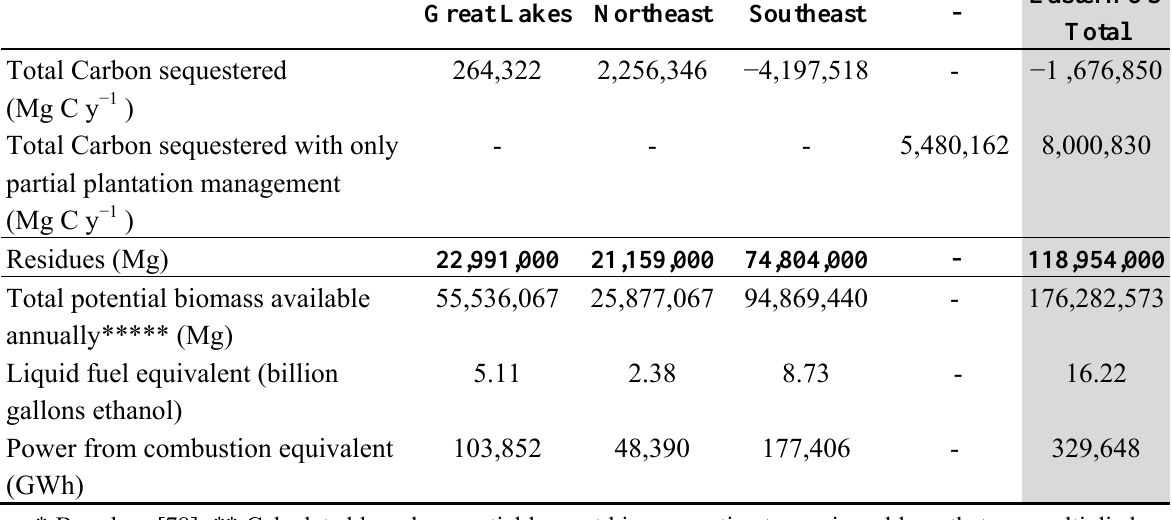
Table 2. Cont. Great Lakes Northeast